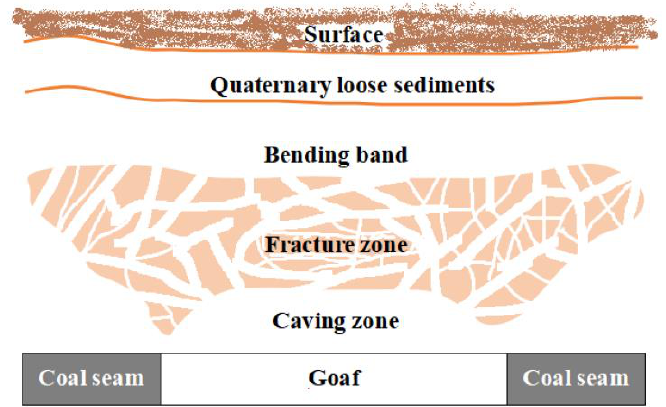
Figure 1. Sketch map of the vertical “ three zones ” in the coal mine goaf areas.